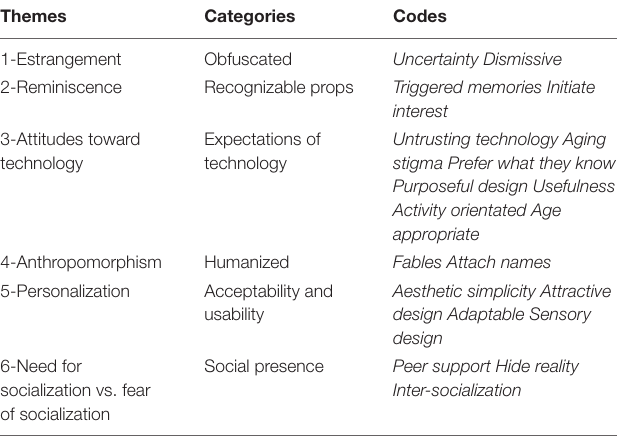
TABLE 2 | Final themes with corresponding categories and